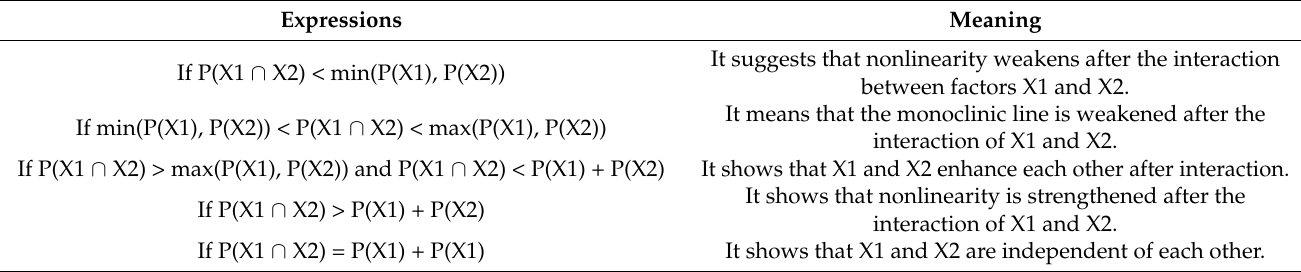
Table 1. The expressions and meaning of interaction